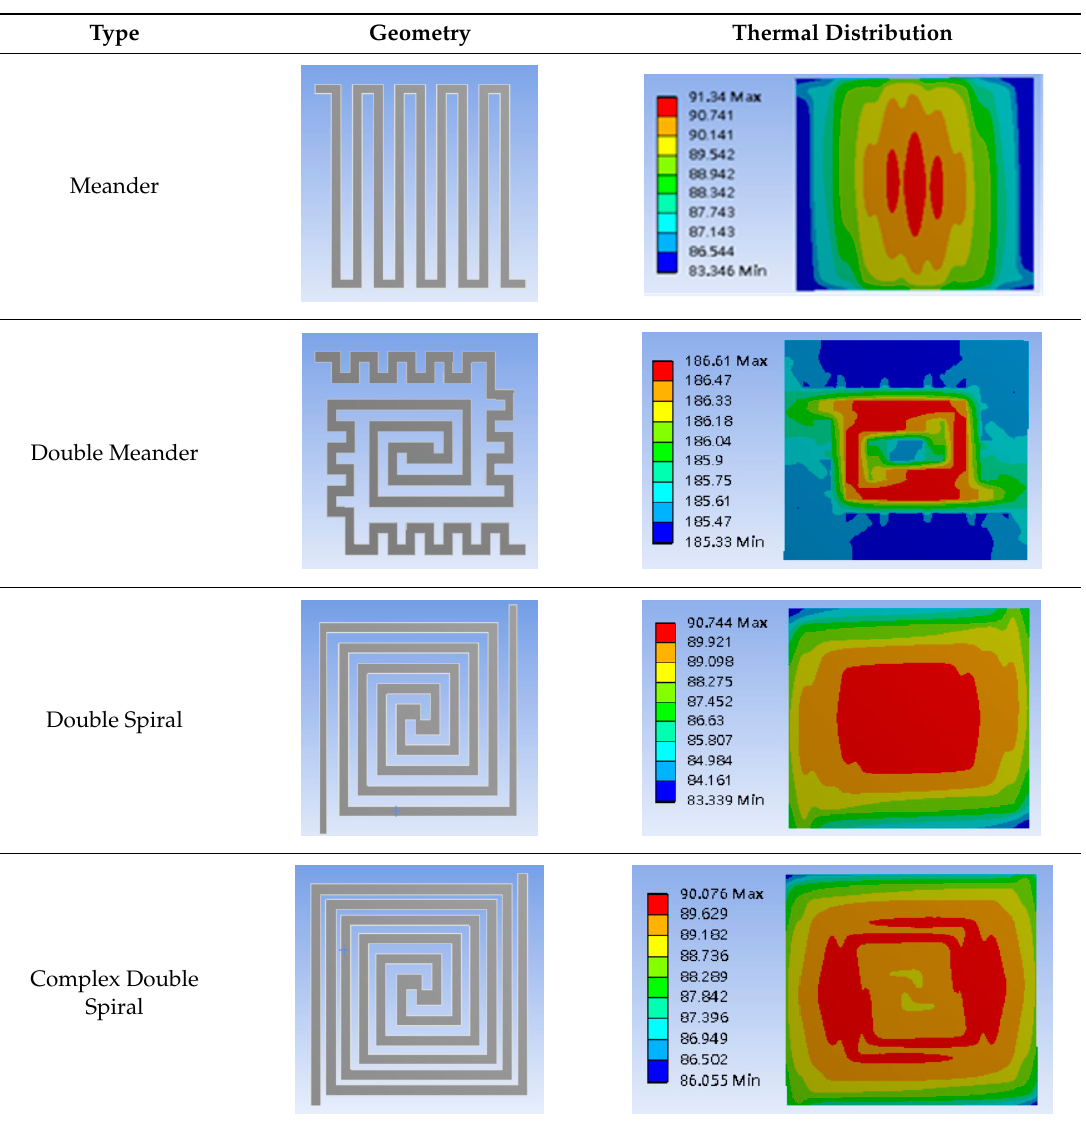
Table 1. Selected geometry of the thermostat and related thermal distribution of each